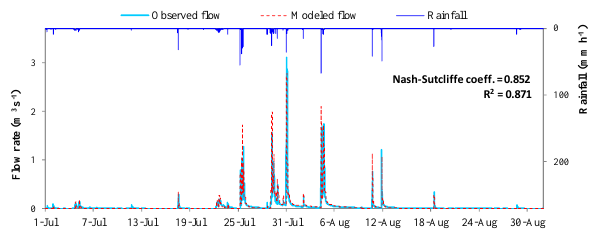
Figure 11. Watershed-scale SWMM modeling results from 1 July 2009 to 31 August